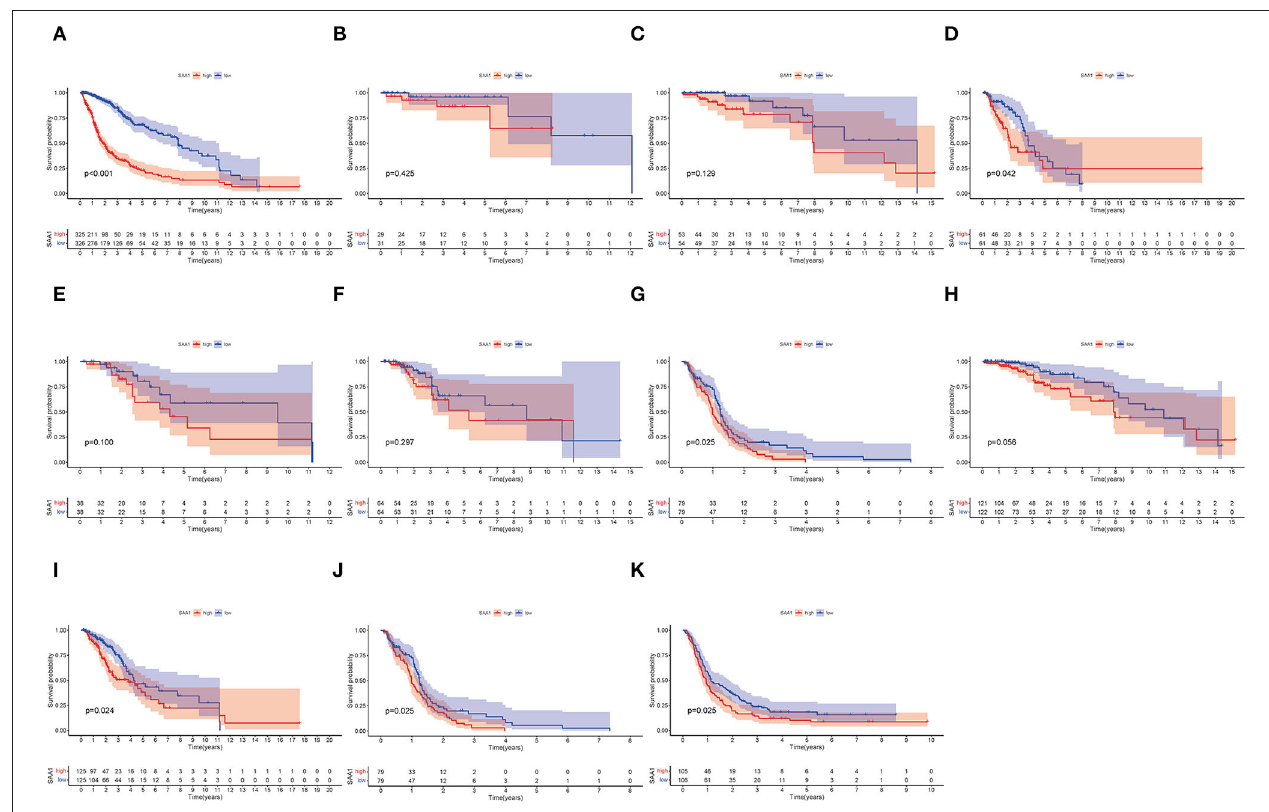
FIGURE 6 | Survival analysis. (A) Survival analysis of all glioma patients with different SAA1 expression levels. Patients were grouped into high and low SAA1 expression groups, and the medians were compared, p < 0.001. (B–G) Survival analysis with different SAA1 expression levels in astrocytoma (A), oligodendroglioma (O), anaplastic astrocytoma (AA), anaplastic oligodendroglioma (AO), mixed glioma (MG), and glioblastoma (GBM), respectively. (H–J) Survival analysis in grade 2, 3, and 4 gliomas, respectively. (K) External validation in CGGA database and survival analysis in SAA1 high- and low-expression groups for